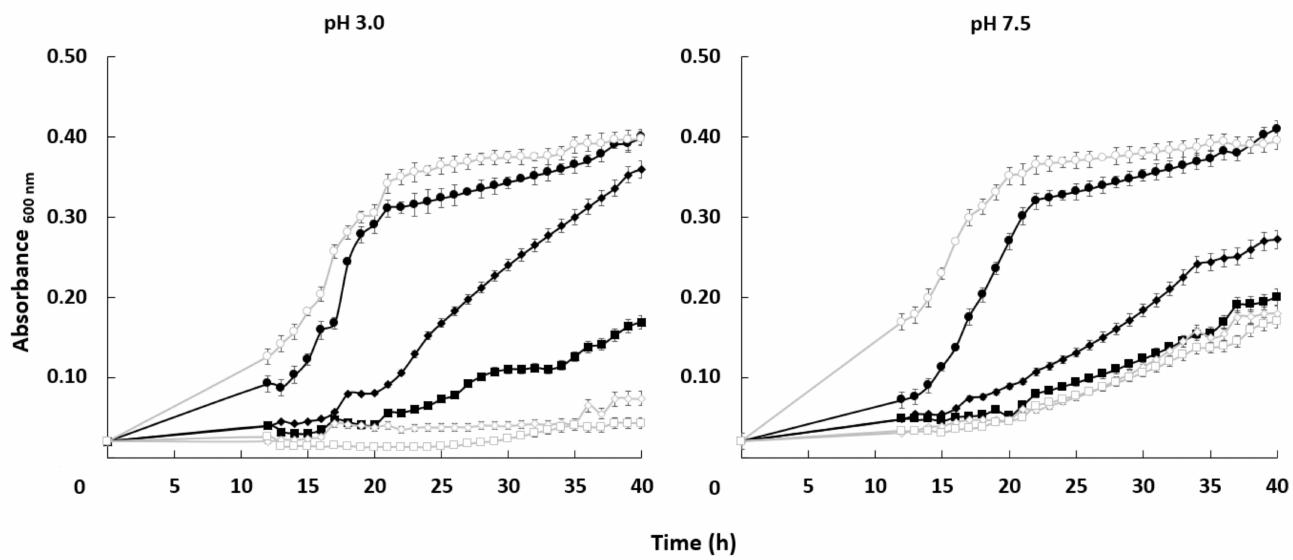
Figure 5. Effect of LiCl on the growth of C. albicans HAK1+ and hak1 − strains at different pHs. Cells were grown in liquid YNB medium supplemented with the indicated amounts of LiCl and adjusted at pH 3.0 or 7.5 as described in the Materials and Methods. The concentrations of LiCl studied were: 0 (circle), 0.15 (diamond) or 0.30 (square) M LiCl. Cultures were inoculated at A 600 0.05 and growth of HAK1+ (filled symbols) and hak1 − (open symbols) strains was monitored during 40 h. Mean values ± standard deviation obtained in three independent experiments are